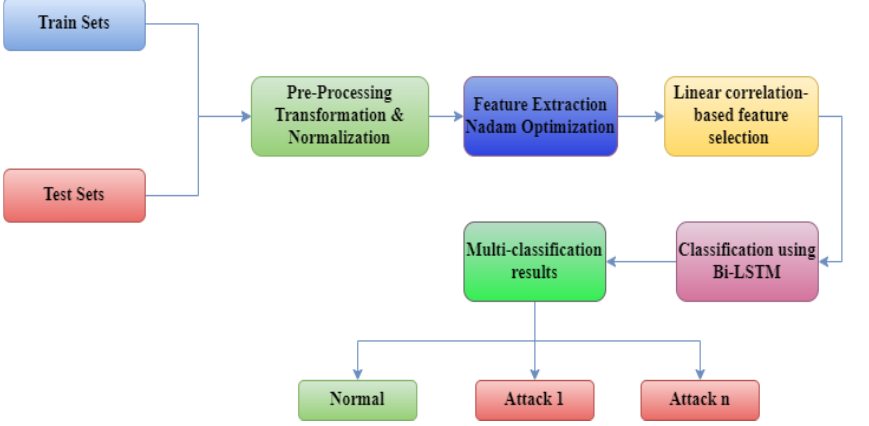
Figure 2. Proposed Model Multi-class Bi-LSTM